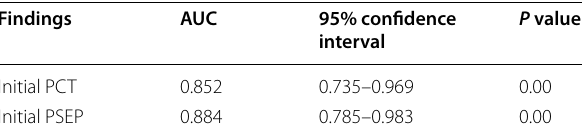
Table 9 Correlation between biomarkers and Flynn